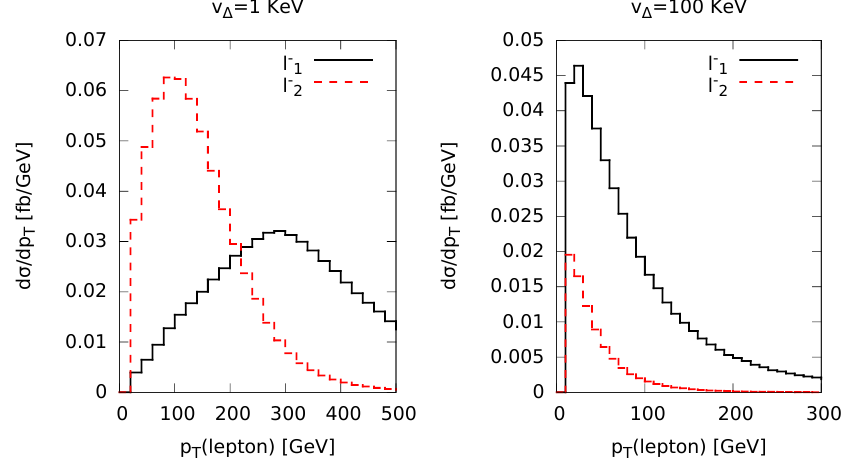
Figure 17 . Transverse momentum ( p T ) distributions of hardest and second-hardest same-sign lepton after ordering the leptons according to their p T hardness ( p l and large (right panel) v (cid:1) . m (cid:1) = 500 GeV is assumed. v , respectively. For small v (cid:1)